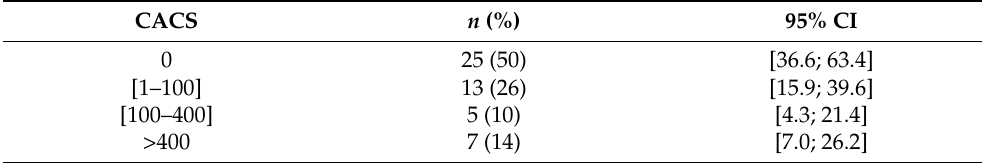
Table 3. CACS values for the 50 rheumatoid arthritis patients.